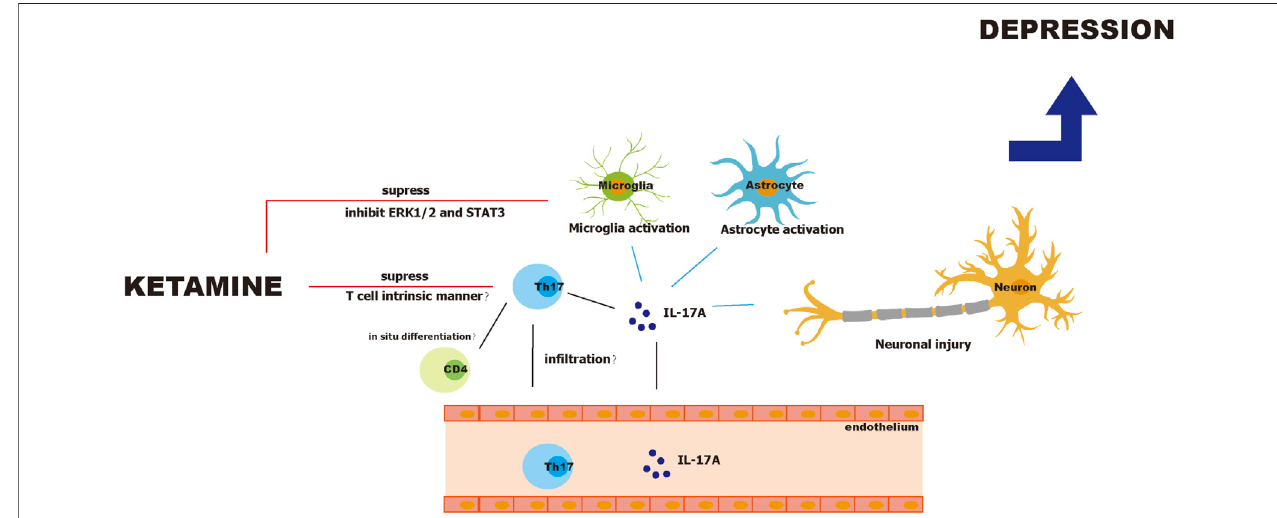
FIGURE 2 | Pathophysiology of Th17 cells in depression and antidepressant effects of ketamine.